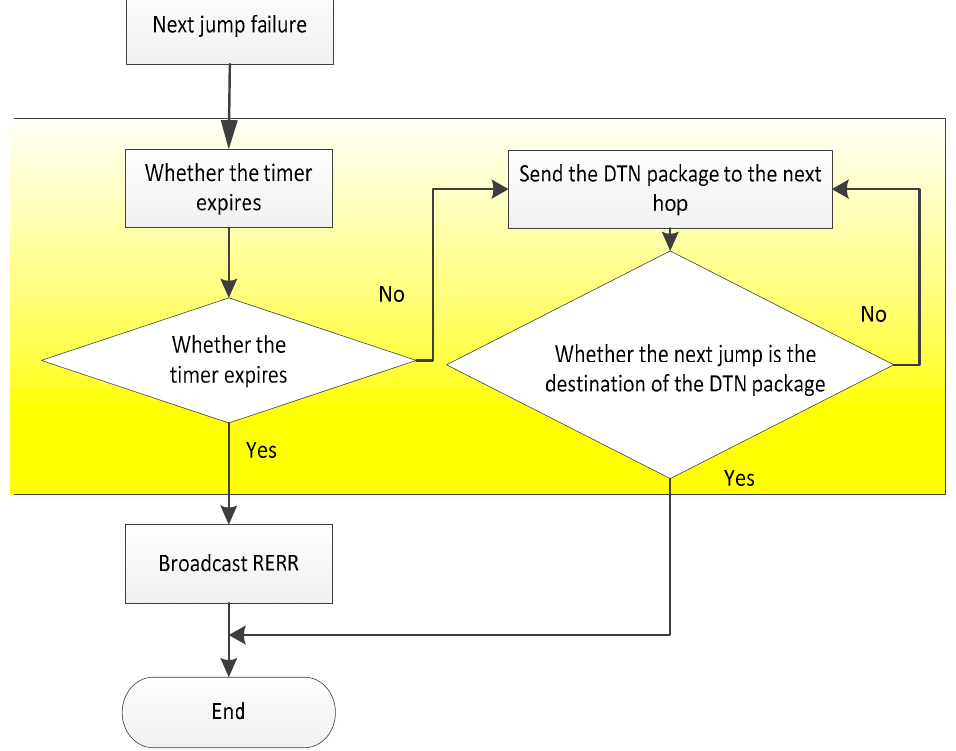
Figure 7. DTN initialization module processing and main control process.